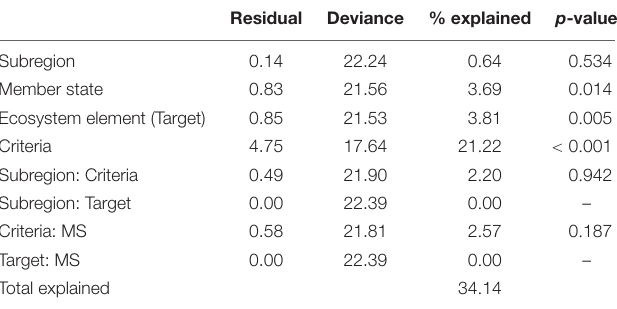
TABLE 3 | Generalized linear models (GLMs) with gamma distribution applied to the average trend data for Descriptor 4—Food webs, per subregion, Member State, criteria, ecosystem element, and their corresponding interaction.